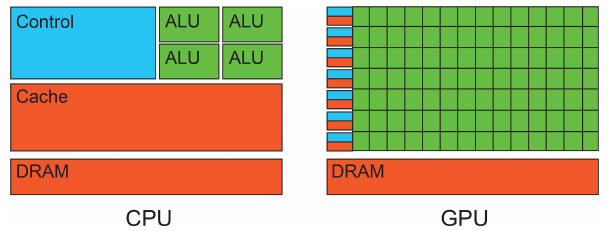
Figure 2. Schematic chip representation for both the central pro- cessing unit (CPU) and graphical processing unit (GPU) architec- ture. The GPU architecture consists of thousands of arithmetic and logical units (ALUs). On the CPU, most of the on-chip space is de- voted to controlling units and cache memory, while the number of ALUs is significantly